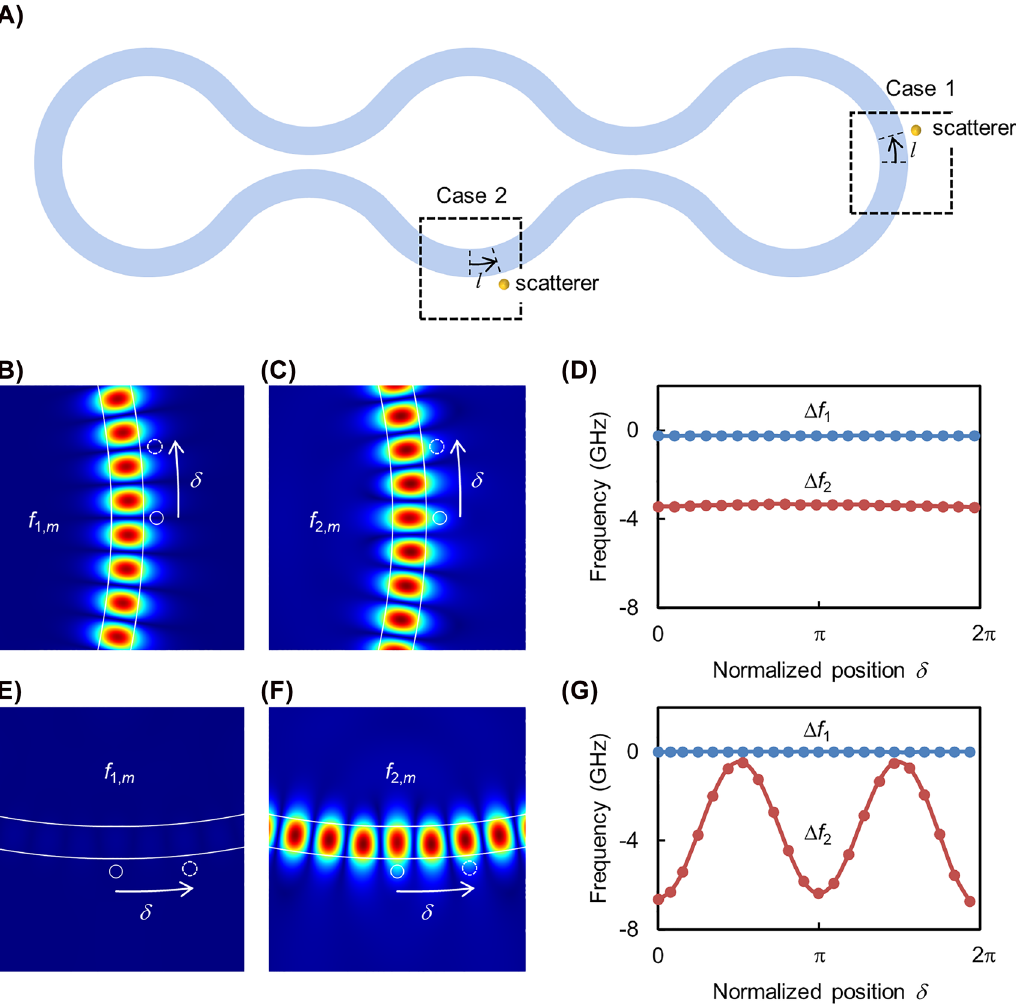
Figure 4: Effect of local perturbation. (A) A schematic of the resonator structure with nanoparticles scatterers added in the traveling wave (case 1) or standing waves (case 2) regions. In case 1, the presence of the scatterer generates two new optical modes that exhibit either a node (B) or an antinode (C) at the location of the particle with corresponding frequency shifts as shown in (D). In this case, the frequency shifts are independent of the particle location as long as it resides in the traveling wave domain. In case 2, the scatter leaves one of the modes intact with zero frequency shift (E) while at the same time introduces a perturbation to the second mode (F) with a frequency shift that varies with the location of the particle as expected (G). In both cases, 𝛿 = 2 𝜋 corresponds to a distance of 0.5 μ m along the perimeter. A rigorous derivation of these results as well as their intuitive explanations are discussed in the main text. In the figure, Δ f j = 1 , 2. The scatterers in panels (B), (C), (E) and (F) are indicated by small white